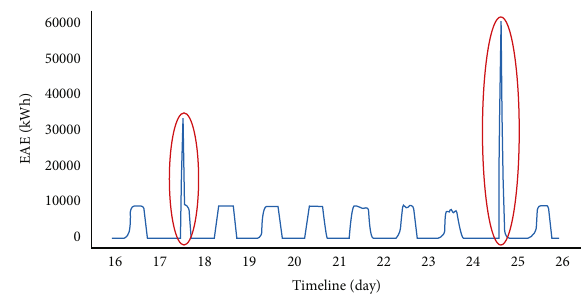
Figure 3: Exploratory sample of extreme values in the EAE variable.